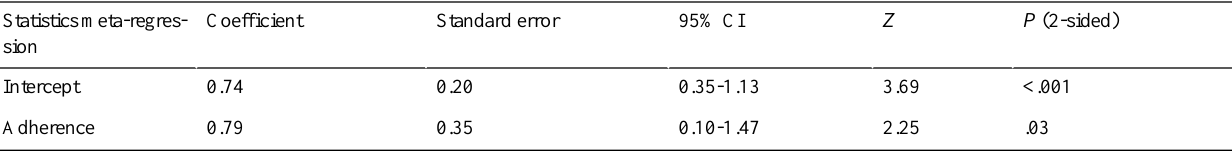
Table 4. Statistics of the meta-regression of adherence and effect size of the individual